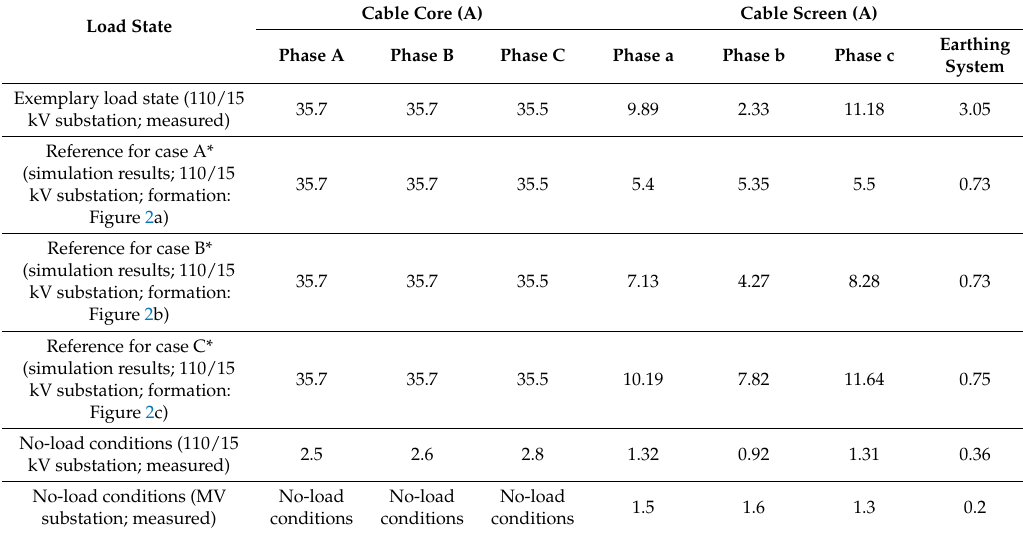
Table 1. Current flow in the cable cores and the screens.